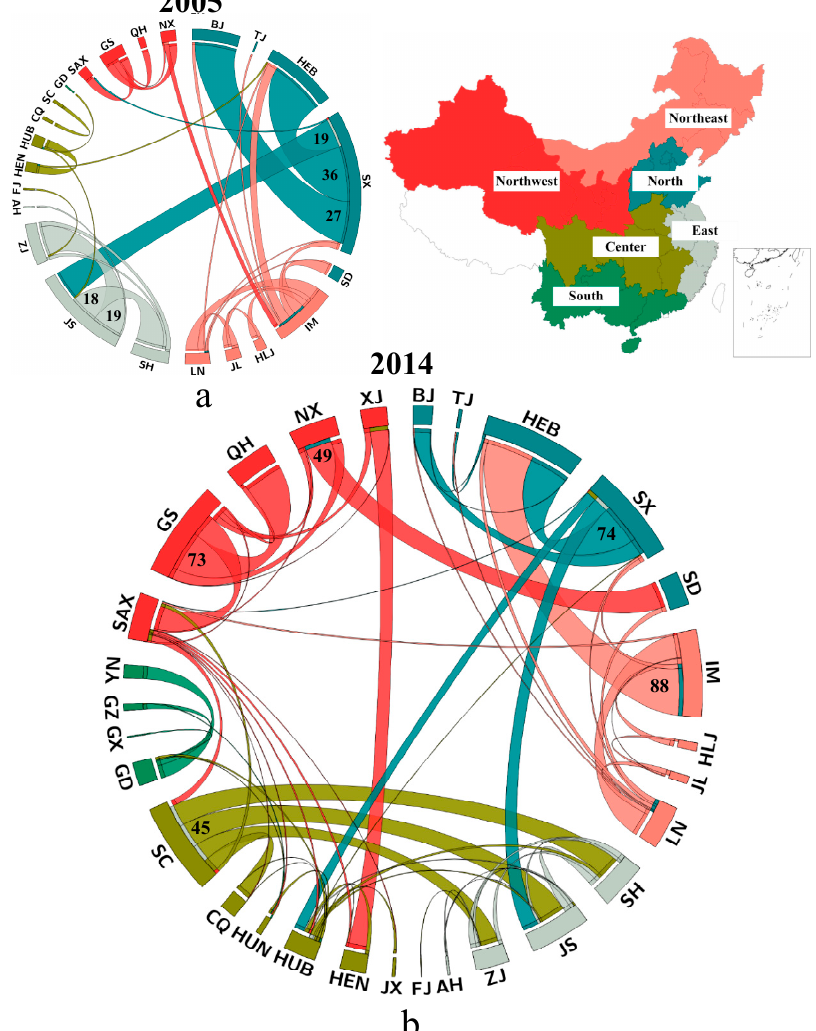
Figure 3. Pair-wise virtual scarce water flows between provinces in 2005 ( a ), and 2014 ( b ). The top five flows are labeled. The color of the ribbon represents the different subnational grid. The ribbon touches inner circle refers to the export, while out of touch means an import. AH ― Anhui, BJ ―